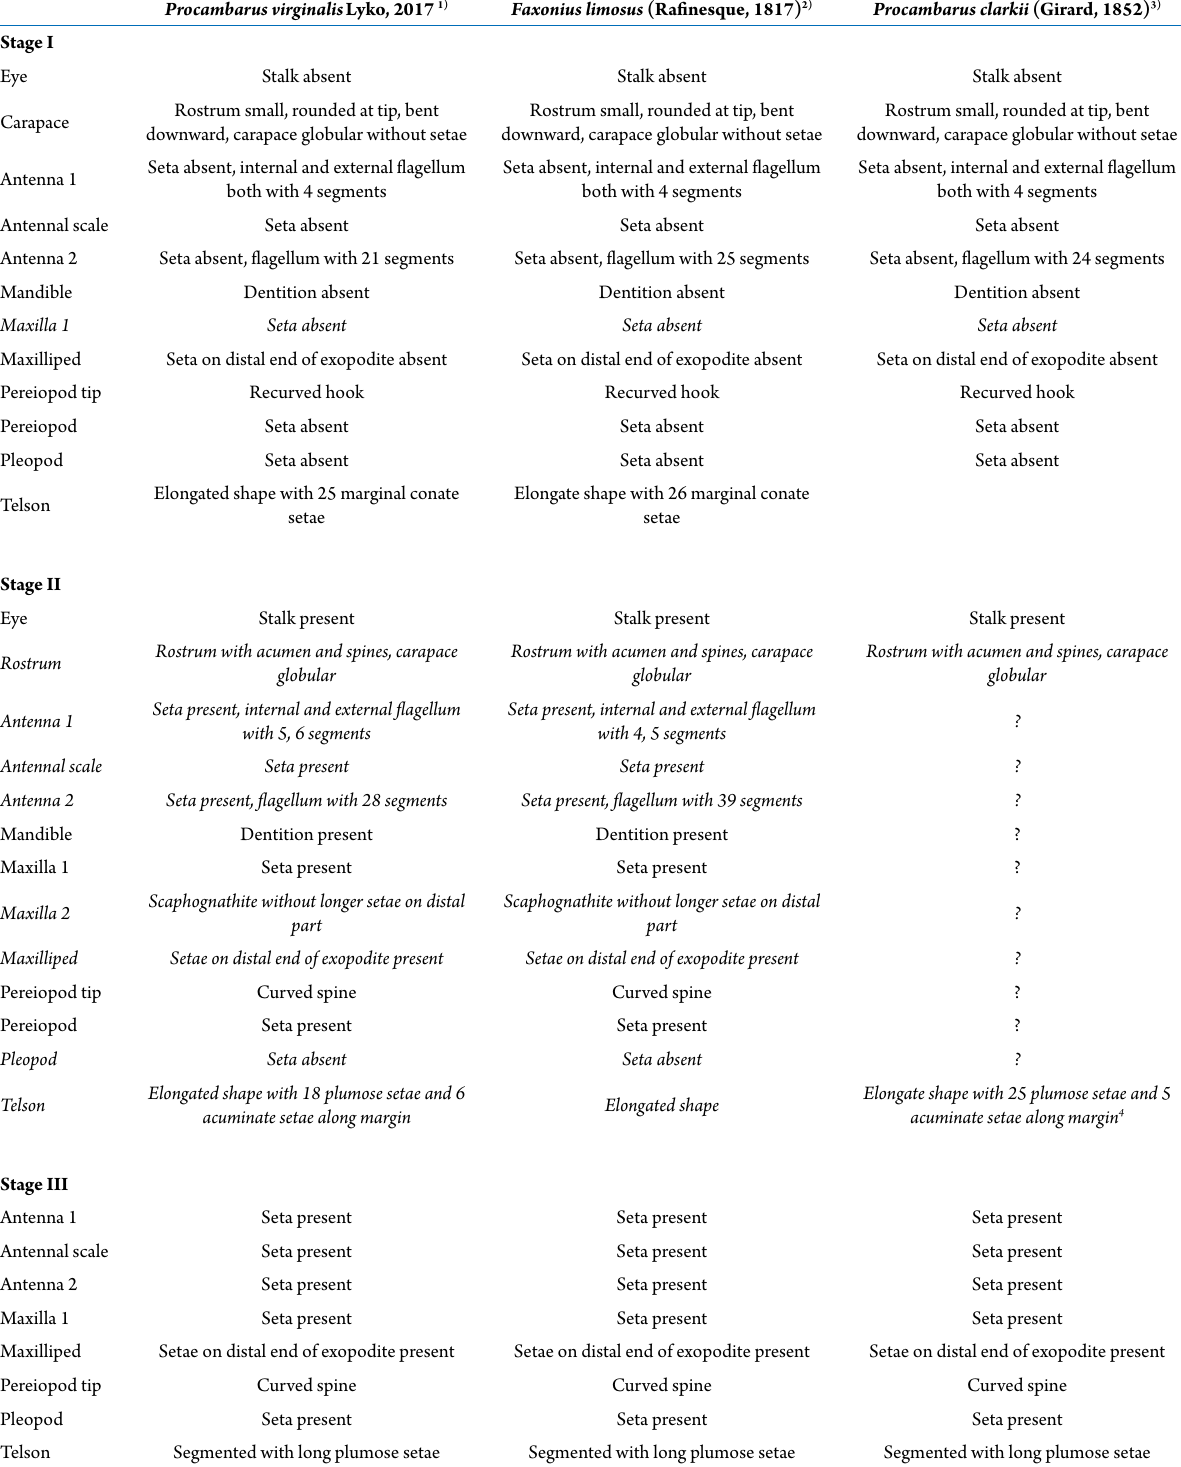
Table 2. Comparison of the morphology of postembryonic stages of Cambaridae members. Procambarus virginalis Lyko, 2017 1) Faxonius limosus (Rafinesque, 1817) 2) Procambarus clarkii (Girard, 1852)